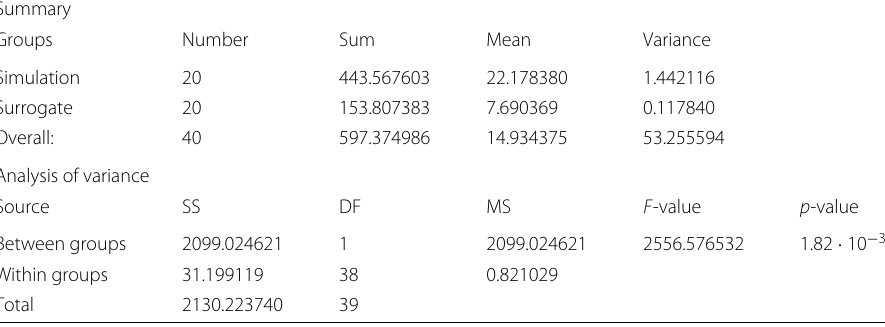
Table 1 Comparison of the simulation time in seconds with and without surrogate model in the upper